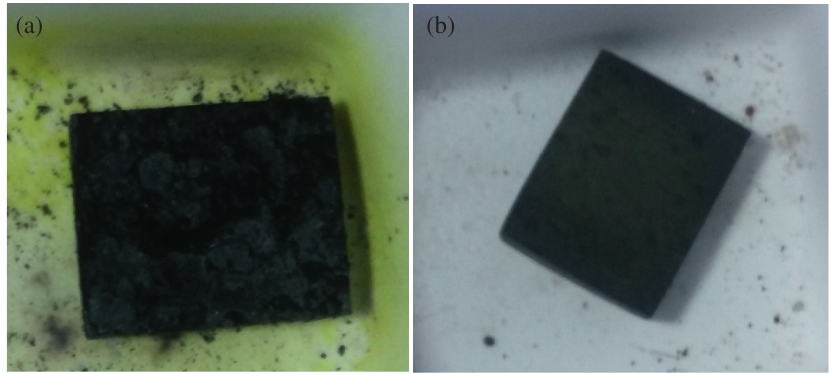
Figure 1: The photo image of the samples exposed to 1000°C to (a) Na 2 SO 4 and NaCl [75% Na 2 SO 4 + 25% NaCl (in wt. %)] and (b) atmospheric